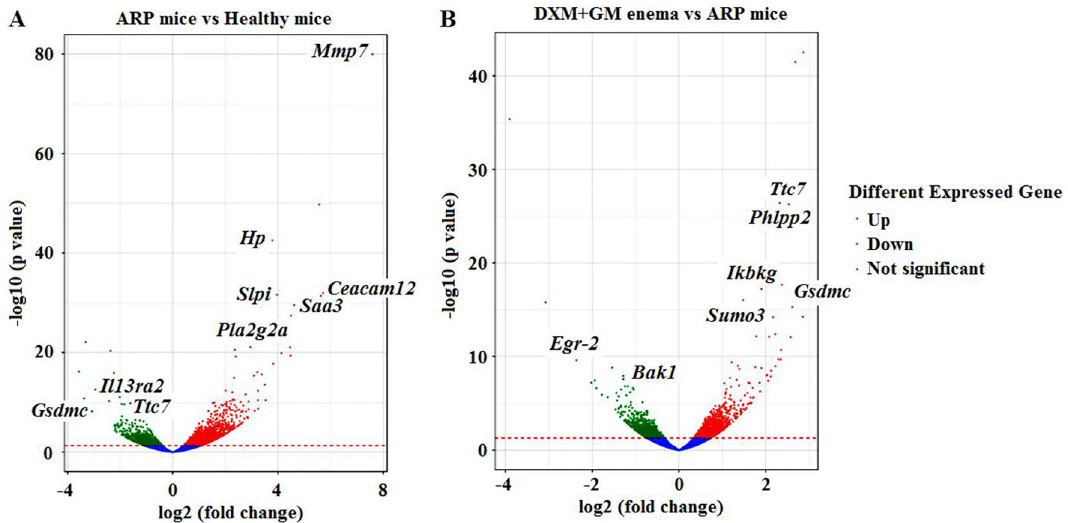
Figure 3. DXM + GM enema regulates the inflammation-induced angiogenesis in ARP mice. Transcriptome sequencing was used to analyze the difference in expression of signaling pathways between healthy mice and ARP mice treated with or without DXM + GM enema. ( A ) Volcano plots of differentially expressed genes between ARP mice and healthy mice. In the volcano plots, each dot is a gene, the “red” genes are those were significantly up-regulated while the “green” genes are those were significantly down-regulated in ARP mice compared with healthy mice at a q value < 0.05. However, the “blue” genes shown there were no significantly difference between ARP mice and healthy mice. In total, 1424 genes were identified as differentially expressed, including 979 genes those were up-regulated and 445 genes that were down-regulated. ( B ) Volcano plots of differentially expressed genes in ARP mice treated with or without DXM + GM enema. In total, 587 genes were identified as differentially expressed, including 348 genes those were up-regulated and 239 genes that were